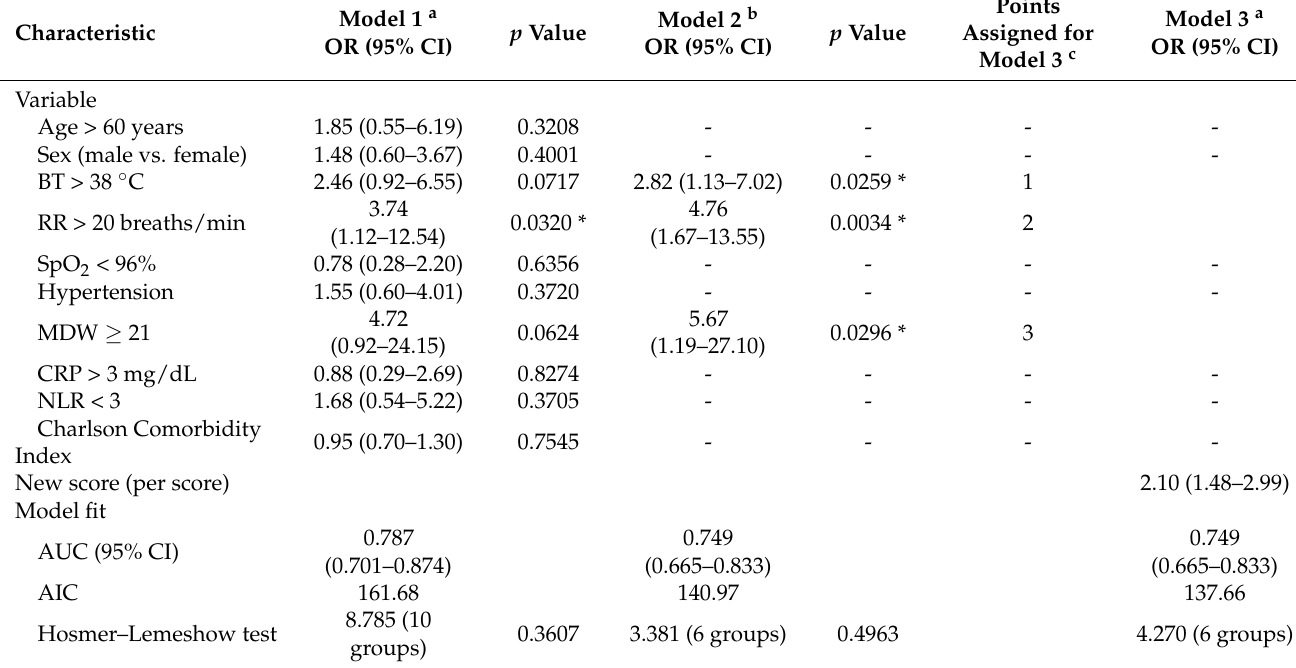
Table 3. Multivariable analysis for predicting length of stay >14 days ( n = 120).